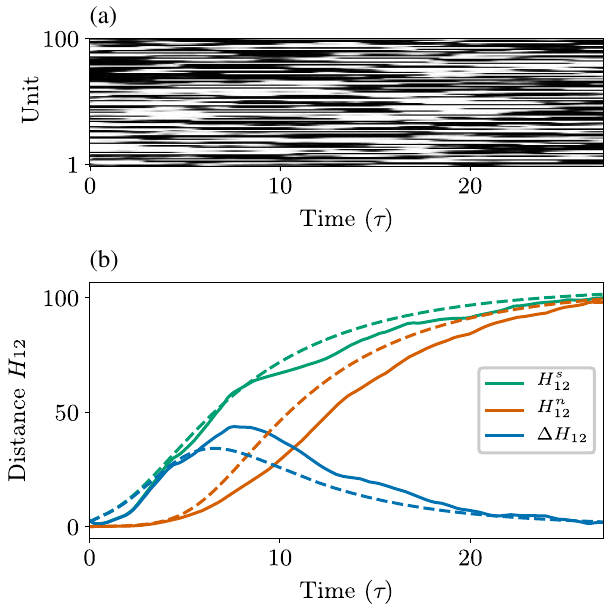
FIG. 9. Evolution of trajectories in a chaotic rate network. (a) Chaotic network activity for N ¼ 250 , g ¼ 5 . 8 , σ 2 T ð h Þ ¼ tanh ð h Þ . Gray scale shows the activity of each neuron between − 1 (white) and 1 (black). (b) Time evolution of average distances between patterns (green) and between noisy realizations of a pattern (dark orange). Difference between signal and noise distances (blue). Numerical solutions of Eq. (24) (dashed); for details, see the Appendix 6. Network as in (a) and P ¼ 50 , L ¼ 10 , σ ¼ 0 . 3